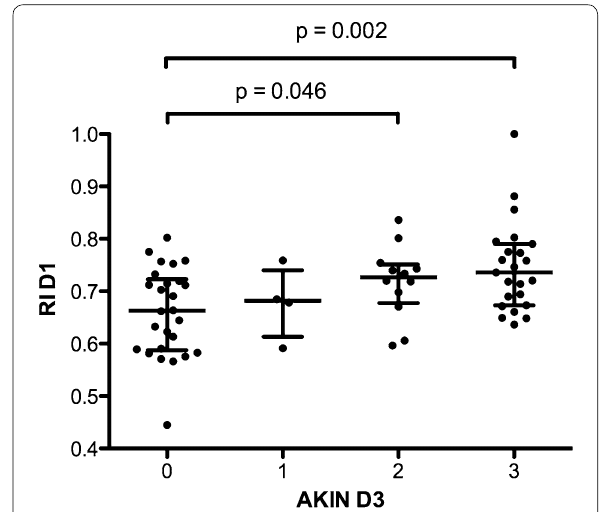
Fig. 2 Distribution of renal resistive index at day 1 (RI D1) according to AKIN classification at day 3 (AKIN D3). RI D1 corresponds to the mean of RI measured for each patient at different mean arterial pressure levels over a period of 20 min on the ICU admission day. Horizontal lines represent median, first and third quartile values for each group. Overall comparison: p 0.01 =